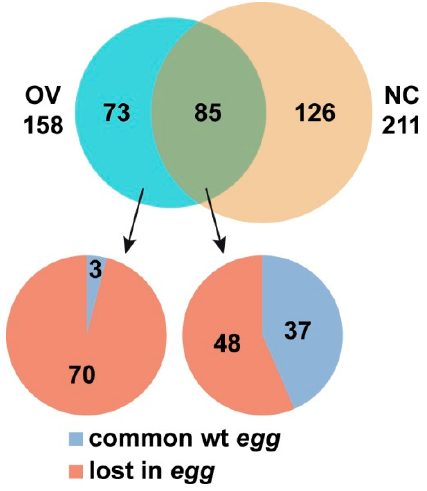
Figure 6. Venn-diagrams showing the numbers of genes that are associated with SU(VAR)3-9 in the ovary in a differentiation-associated manner (upper part); sub-grouping of these gene targets depending on the egg effects (bottom part). NC and OV—nurse cells and germline cells of juvenile ovaries, respectively(wild type in both cases). “Common wt egg ”—gene targets shared between wild type and egg profiles. “Lost in egg ”—genes that are associated with SU(VAR)3-9 only in the presence of